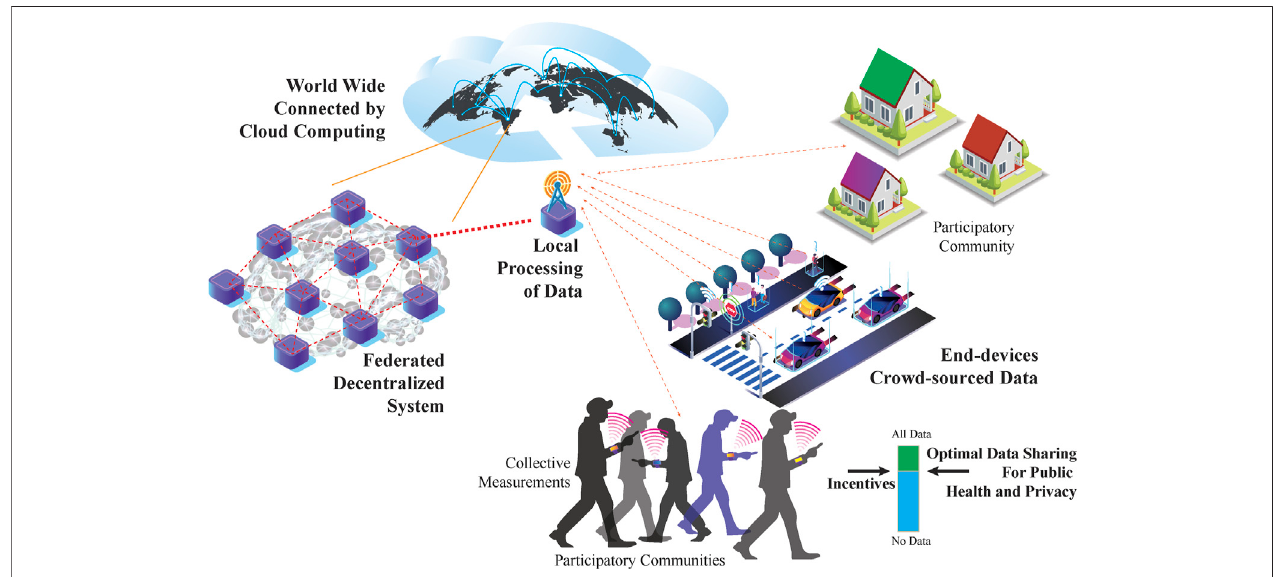
FIGURE 1 | A federated ubiquitous systems for epidemiological warning and response. An organic and bottom-up scaling at global level is envisioned based on active citizens ’ participation. Decentralized privacy-preserving computations are performed from the edge to the cloud based on crowd-sourced obfuscated and anonymized data managed with distributed ledgers to empower trust. Incentive mechanisms for responsible data sharing align the public health mandate with citizens ’ privacy and autonomy.